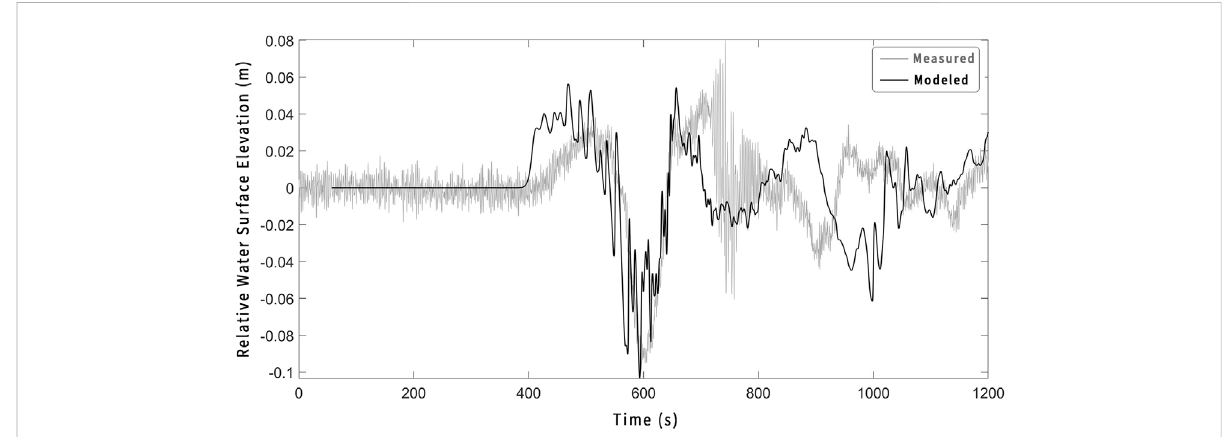
FIGURE 4 Comparison of measured and modeled surface displacements during wake event generated by northbound vessel JS Ineos